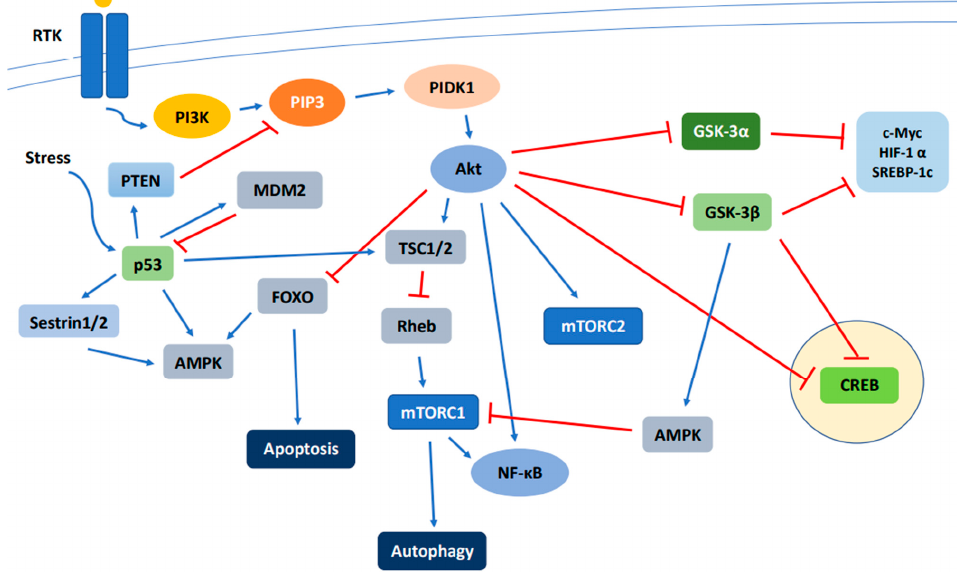
Figure 1. Schematic overview of the major components of the PI3K/Akt/mTOR signaling pathway. Activation of RTK by a ligand in turn activates PI3K, PDK1, and Akt, which regulates downstream effectors including FOXO, mTORC1, mTORC2, CREB, GSK-3 α , and GSK-3 β . Abbreviations: RTK—receptor tyrosine kinase; PI3K—phosphatidylinositol 3-kinase; PIP3—phosphatidylinositol-3,4,5-triphosphate; PDK1—3-phosphoinositide dependent protein kinase 1; Akt—Akt, protein kinase B; TSC1/2—tuberous sclerosis complex subunit 1/2; Rheb—Ras homolog mTORC1 binding; mTOR—mammalian target of rapamycin; GSK-3—glycogen synthase kinase-3; c-Myc—cellular Myc; HIF-1 α —hypoxia inducible transcription factors 1 α ; SREBP-1c—sterol regulatory element binding protein-1c; CREB—cAMP-response element-binding protein; FOXO—forkhead box O protein; AMPK—adenosine monophosphate-activated protein kinase; MDM2—murine double minute 2; NF- κ B—nuclear factor kappa-light-chain-enhancer of activated B cells; PTEN—phosphatase and tensin homolog. Blue line: positive regulation; Red line: negative